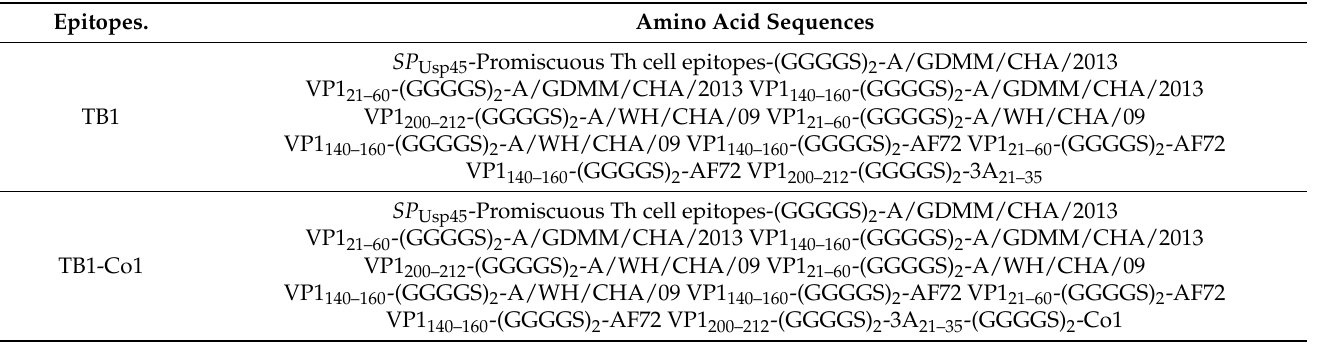
Table 2. Components of recombinant proteins.